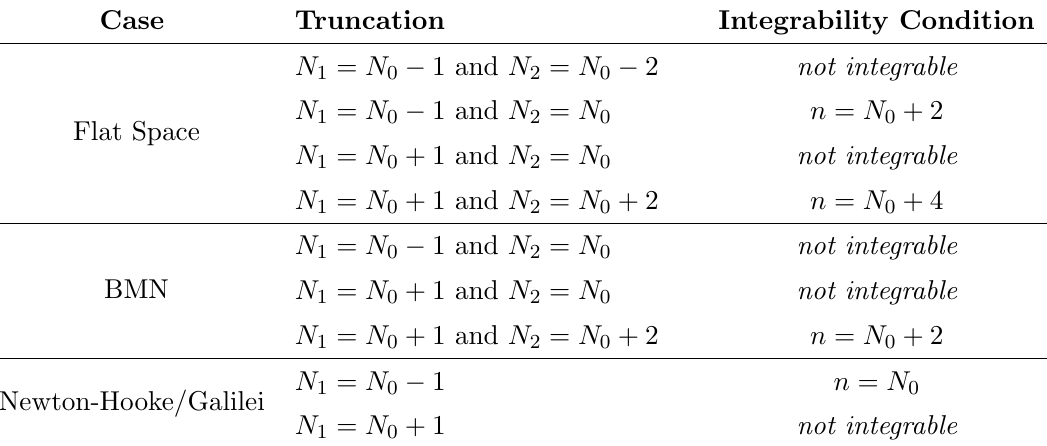
Table 3 . Relations between n and the truncation to be satis(cid:12)ed in order to have an integrable n -th order action. We remark that some truncation are ruled out by the request of